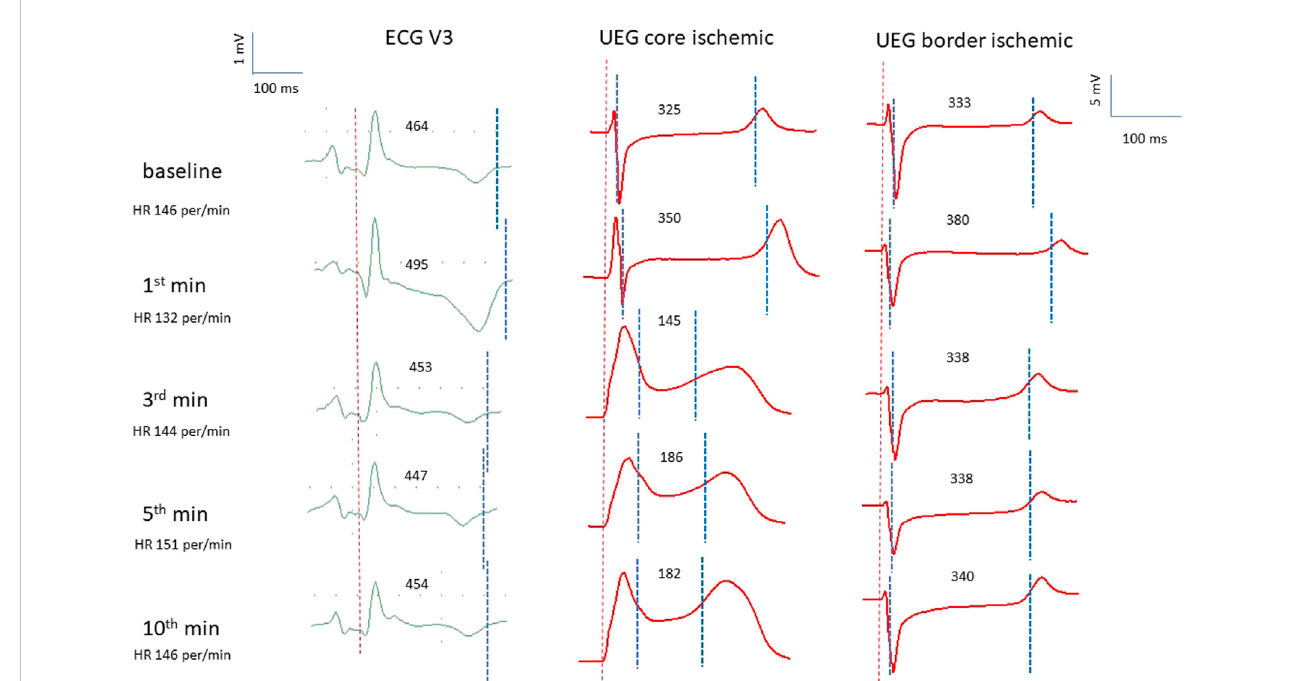
FIGURE 1 Representative electrocardiograms (ECG lead V3), and epicardial unipolar electrograms (UEG) recorded in the core and border ischemic zones in the same pig at the same time-point. Vertical dotted lines indicate the margins of QT interval in ECGs and the margins of ARI in UEGs. In each UEG, the left and rightdottedlinesindicateATandRT,respectively.TheindividualvaluesofARIandQTintervalsarepresentedabovethetracings.SeeQTprolongationatthe1 st min associated with the prolongation of the ARI in the border